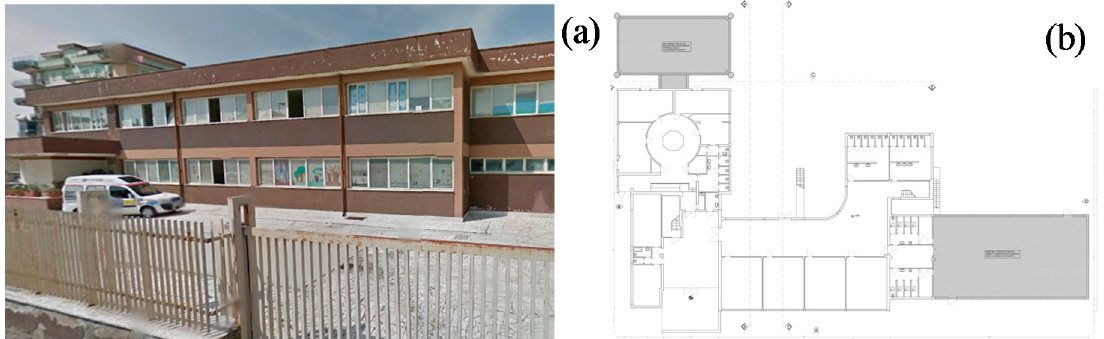
Figure 14. The Cluster 2 reference school building (Building 2): ( a ) actual view; ( b ) building ground floor map.